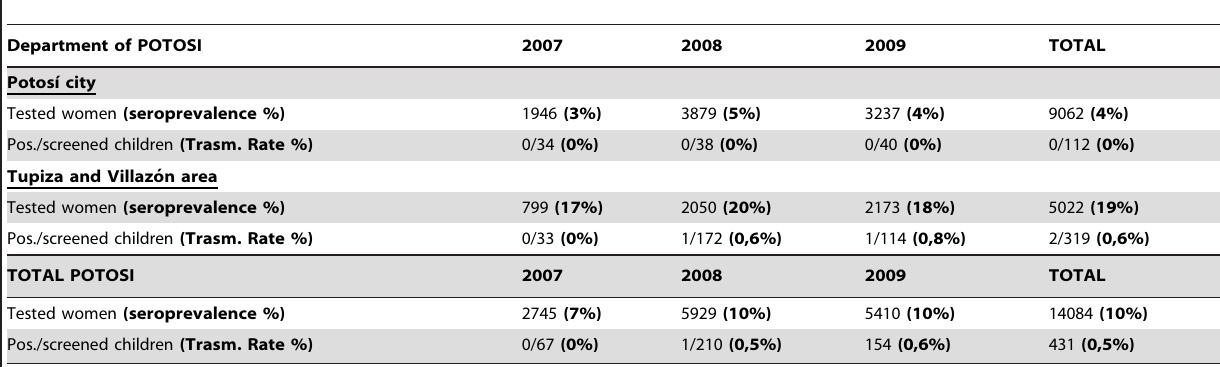
Table 7. Seroprevalence and maternal-fetal transmission rate in the Potosı´ health